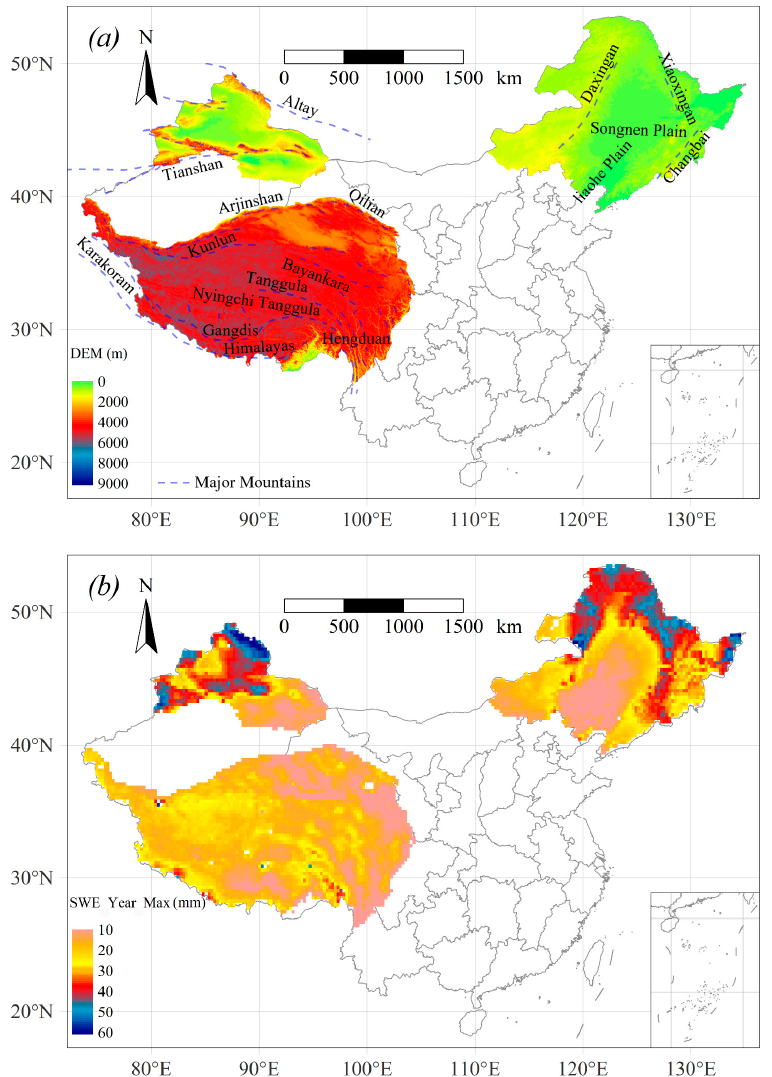
Figure 1. Study regions and their snow distributions. ( a ) Topographic map and main mountain chains in China’s three main stable snow cover regions. ( b ) Mean value of the annual maximum SWE (snow water equivalent) from 1981 to 2020.